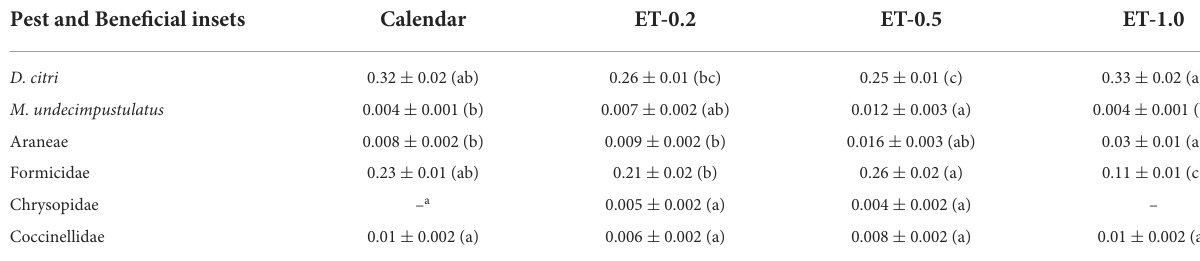
TABLE 4 Differences in overall mean arthropod count ± SE and statistical significance (indicated by different letters in columns) between ET treatment groups within each arthropod category (Tukey LSD: α = 0.05). Pest and Beneficial insets